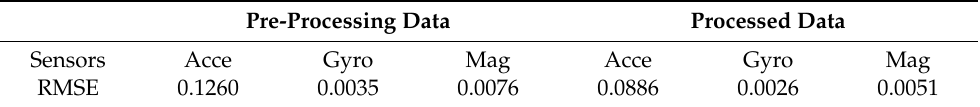
Table 1. Comparison of the RMSE for pre-processing data and processed